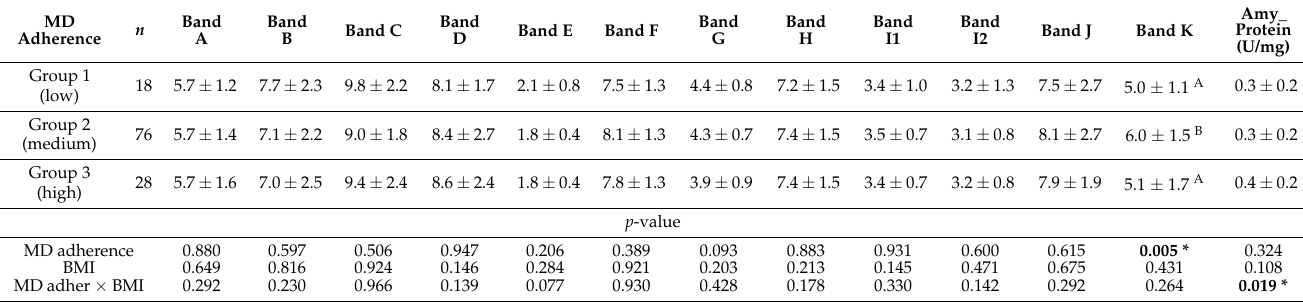
Table 1. Variations in saliva composition between Mediterranean Diet (MD) adherence and Body Mass Index (BMI) groups (means ± SD): a two-way general linear model.